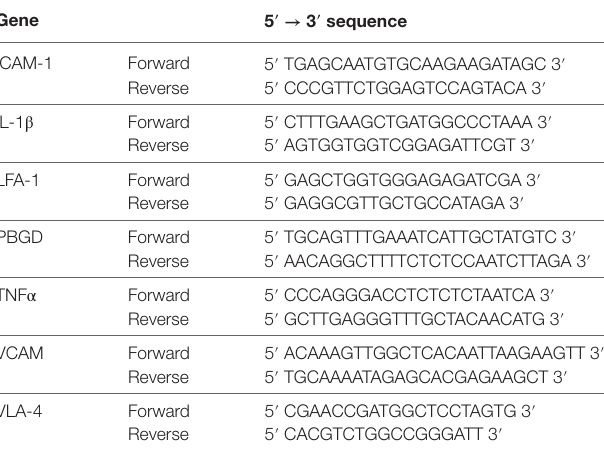
TaBle 2 | Primer sequences used for quantitative PCR experiments. gene 5 ′ → 3 ′